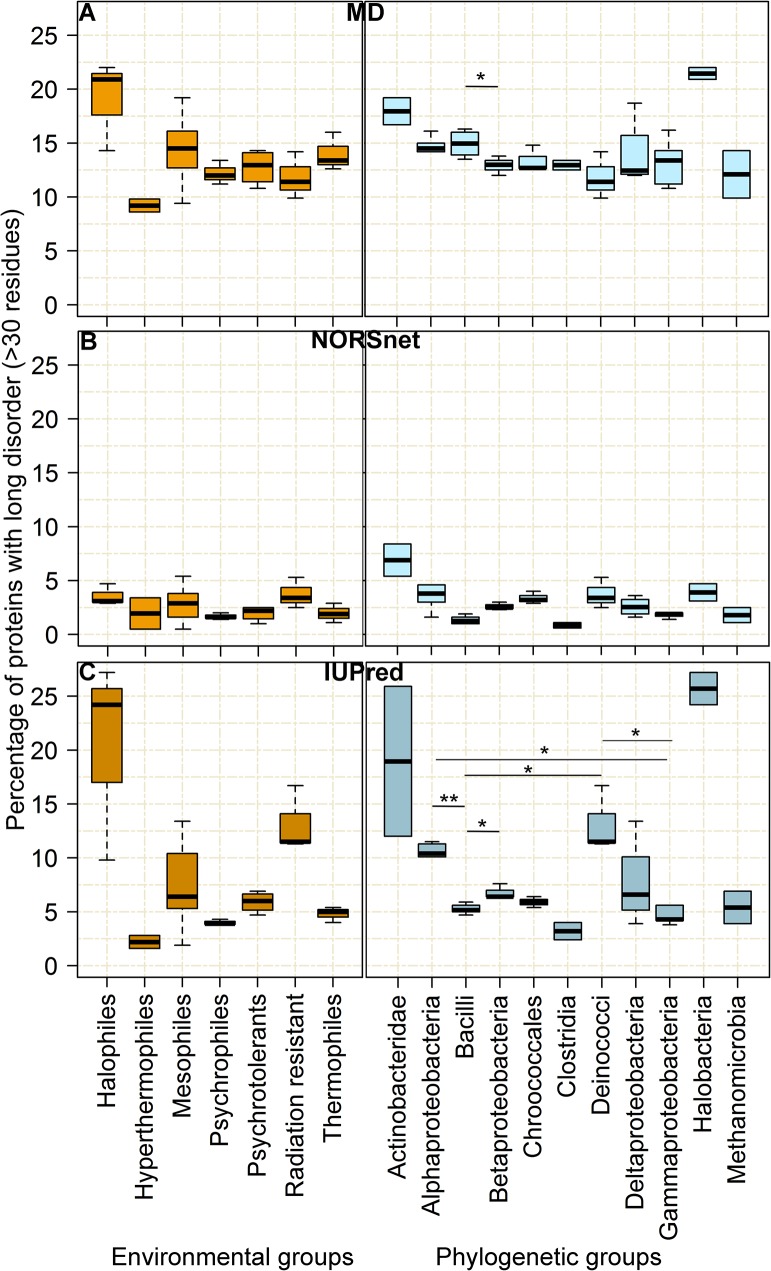
Protein disorder linked to habitat more than to phylogeny.The fractions of proteins with long disordered regions are predicted by two disorder predictor methods (MD in green bars and IUPred in red bars). Eukaryotes are predicted with substantially more disorder than prokaryotes. Within the kingdoms predictions vary greatly: organisms in similar habitats tend to resemble each other in terms of disorder more than they resemble their closest phylogenetic relatives. (A) Hyperthermophilic archaea (dark red) are more ordered than their phylogenetic neighbors; halophilic archaea are more disordered (green). (B) Halophilic bacteria also appear more disordered than their relatives. (C) The bacterial thermophile (red) also has less disorder than its relatives. Other extreme organisms included: psychrophile (blue), psychrotolerant (light blue), radiation resistant (purple) and alkalophile (pink). We could also find organisms with relative high/low disorder content explainable separately.